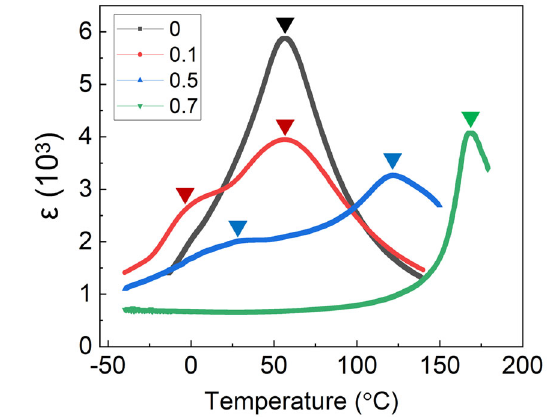
Figure 2. Dielectric permittivity versus temperature curves (10 kHz) for the selected compositions x = 0, 0.1, 0.5, and 0.7 of BZ 0.18 T–xBP 0.22 T.